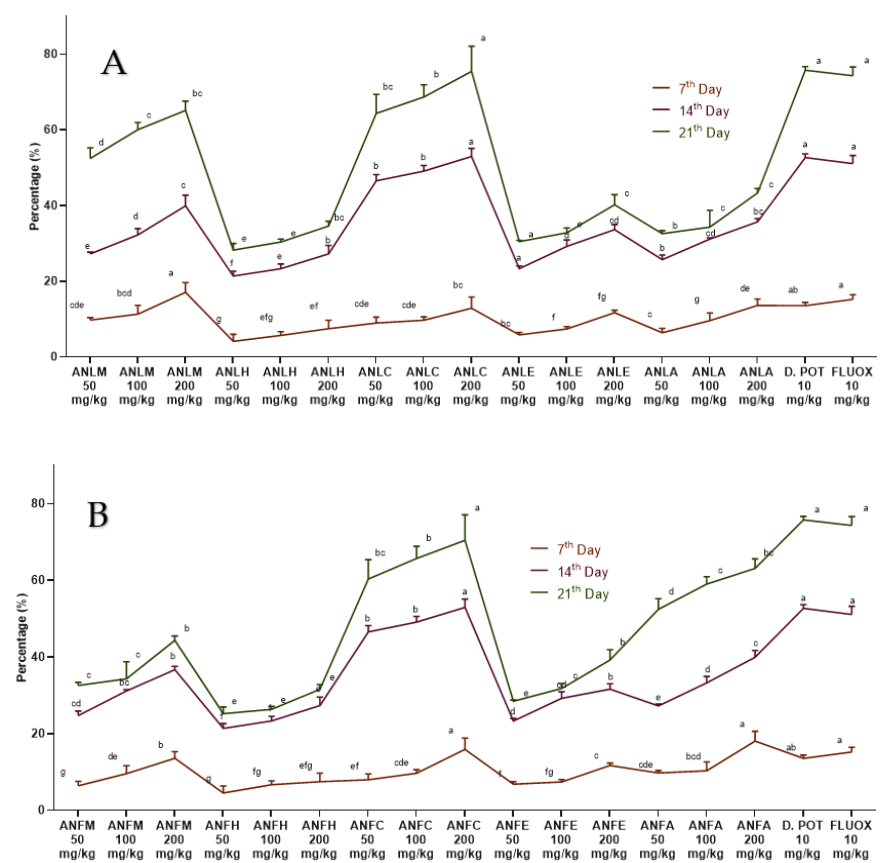
Figure 2. Percentage inhibition of A. nitida on Freunds’ complete adjuvant induced arthritis. ( A ) A . nitida leaves methanolic extract (ANLM), A . nitida leaves n-hexane fraction (ANLH), A . nitida leaves chloroform fraction (ANLC), A . nitida leaves ethyl acetate fraction (ANLE), A . nitida leaves aqueous fraction (ANLA), and ( B ) A . nitida fruit methanolic extract (ANFM), A . nitida fruit n-hexane fraction (ANFH), A . nitida fruit chloroform fraction (ANFC), A . nitida fruit ethyl acetate fraction (ANFE), A . nitida fruit aqueous fraction (ANFA). D.POT: Diclofenac potassium; FLUOX: Fluoxetine. Data were